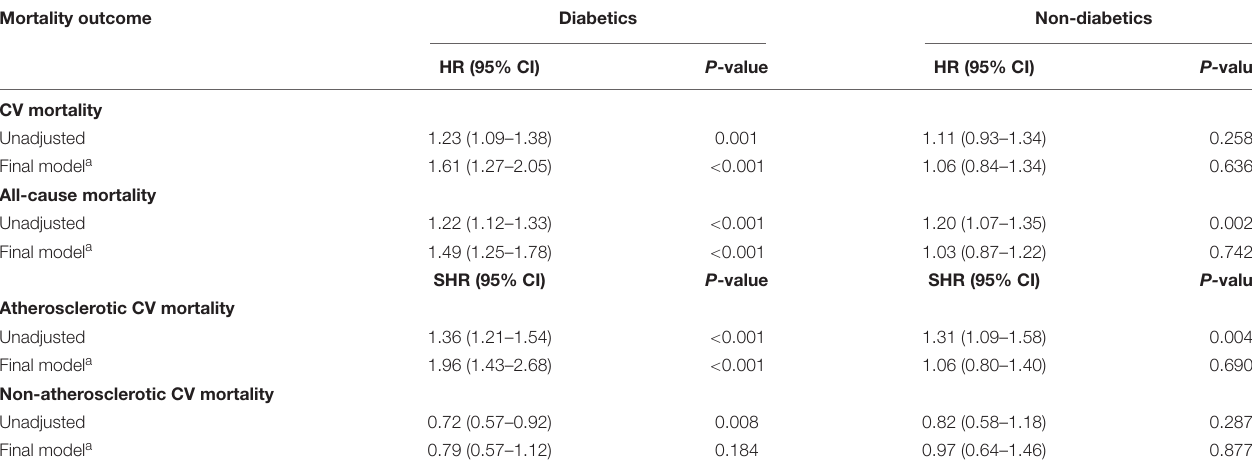
TABLE 4 | Mortality outcome for each 1-SD increase in apo B/apo A1 ratio level by diabetes. Mortality outcome